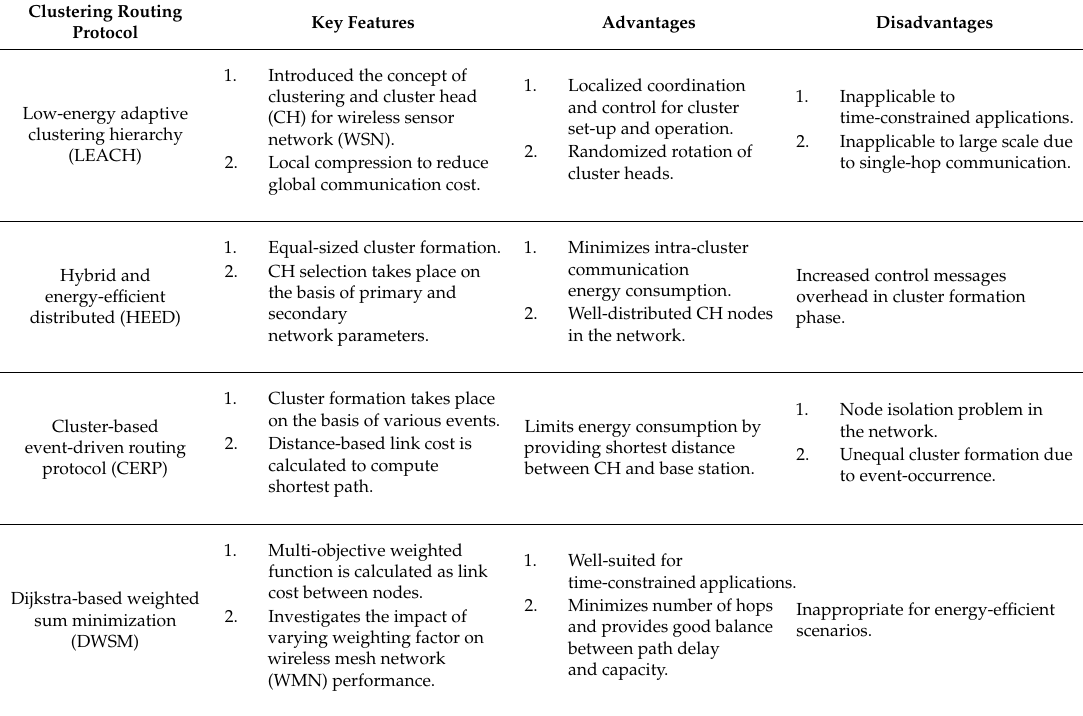
Table 1. Key characteristics, advantages, and disadvantages of some cluster-based routing protocols. Clustering Routing